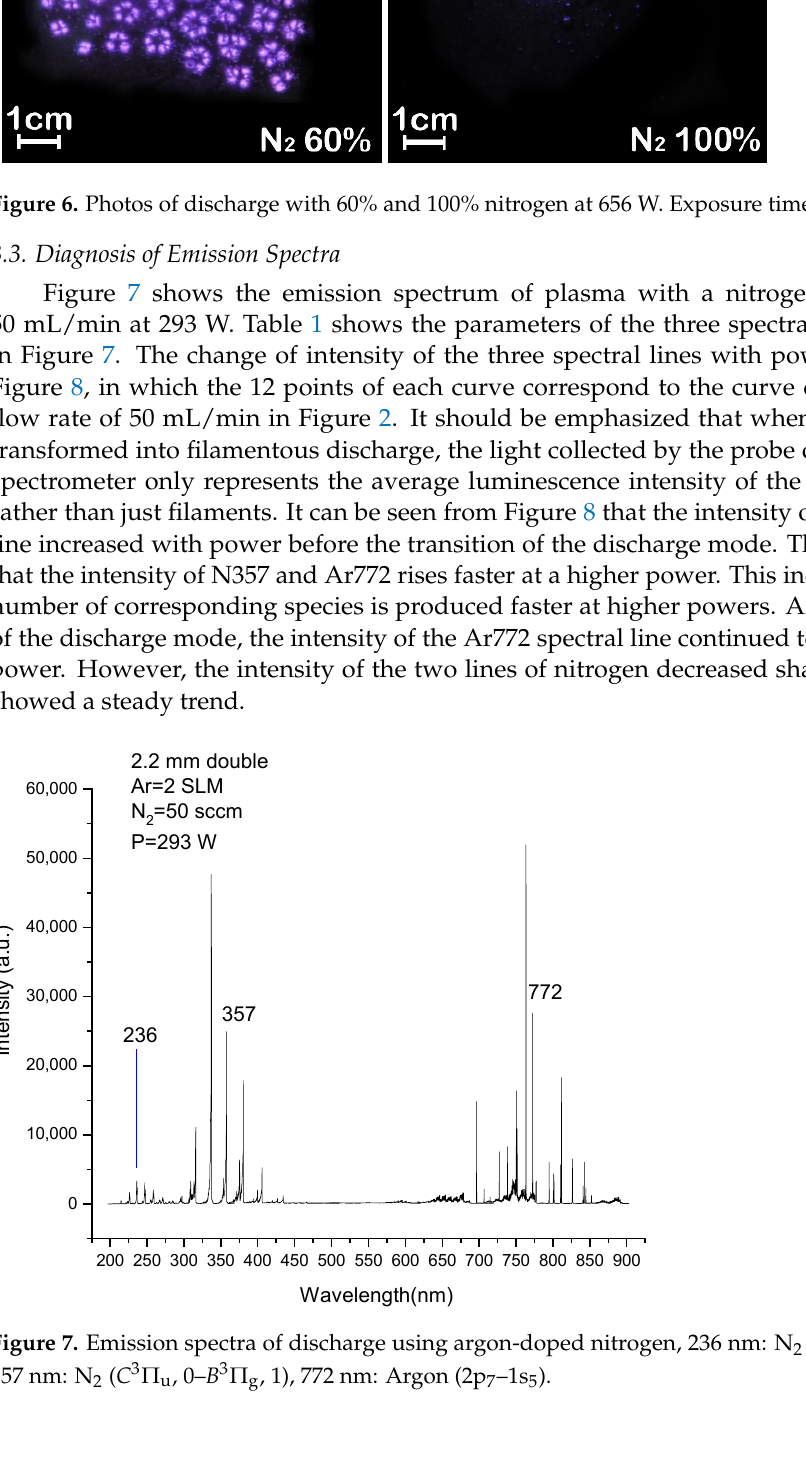
Figure 6. Photos of discharge with 60% and 100% nitrogen at 656 W. Exposure time: 1 ms.